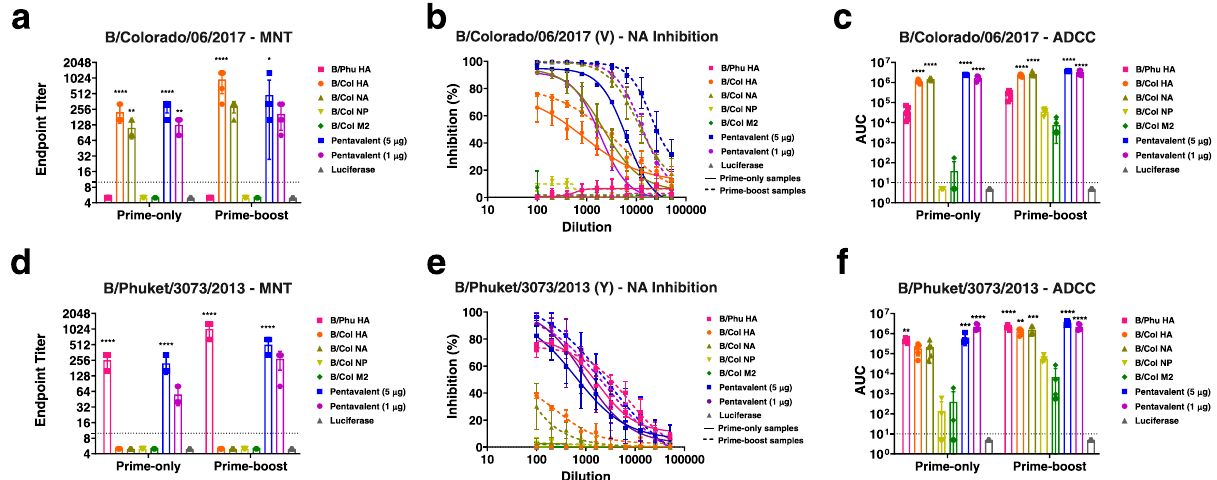
Fig. 4 | Functional characterization of antibodies against B/Colorado/06/2017 (V)andB/Phuket/3073/2013(Y). Micewerevaccinatedandserawerecollectedas described inFig. 2.Functionalcharacterization ofantibodiesinthe prime-onlyand prime-boost sera of mice vaccinated with mRNA-LNPs was performed in micro- neutralization (MNT) ( n =5) ( p -values left to right <0.0001, 0.0047, <0.0001, 0.0011, <0.0001, 0.0154) ( a ), NAI ( n =3) ( b ), or ADCC reporter ( n =5) ( p <0.0001 for all comparisons) ( c ) assay against B/Colorado/06/2017 (V) in fl uenza virus. Functionalcharacterizationofantibodiesintheprime-onlyandprime-boostseraof mice vaccinated with mRNA-LNPs was performed in MNT ( n =5) ( p -values left to right <0.0001, <0.0001, <0.0001, <0.0001) ( d ), NAI ( n =3) ( e ), or ADCC reporter ( n =5) ( p -values left to right 0.0059, 0.0006, <0.0001, <0.0001, 0.0017,